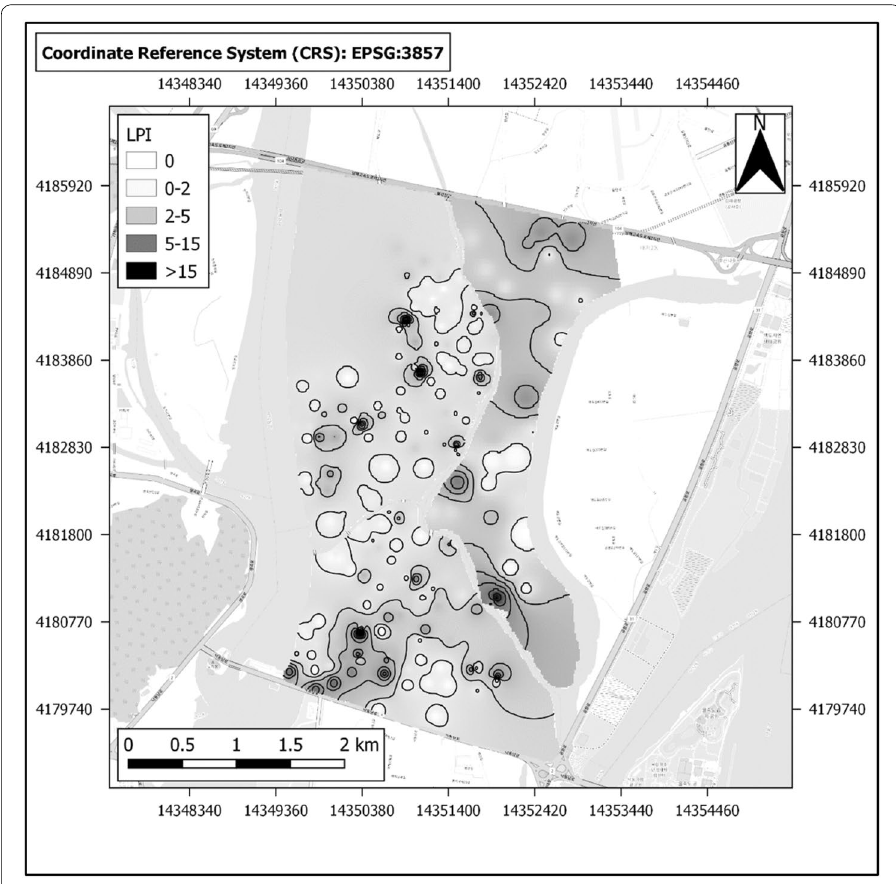
Fig. 18 Liquefaction hazard map based on DSHB [8] method for case